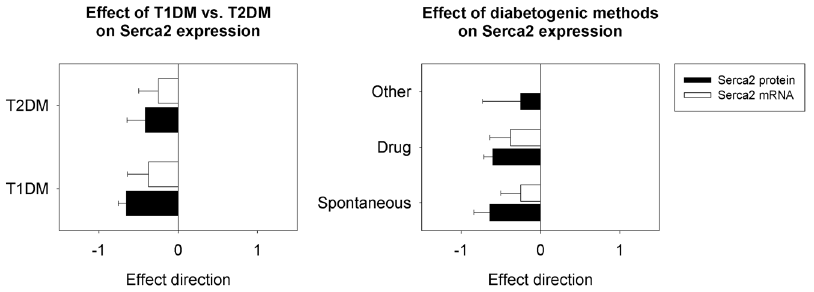
Figure 4. Effect of diabetes type and methods of diabetogenicity on cardiac Serca2 expression. Serca2 is not affected by either diabetes type or by different methods of inducing diabetes in the hearts of experimental rodent models of diabetes. T1DM = type 1 diabetes mellitus;